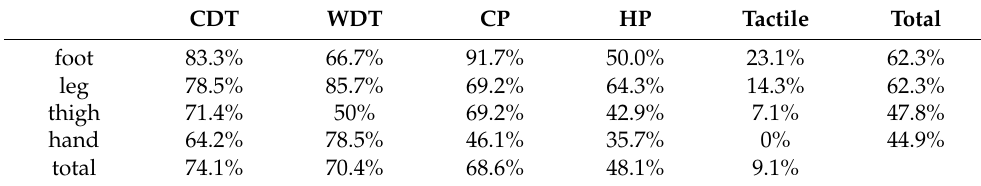
Table 2. Abnormal frequency for each site and thermal